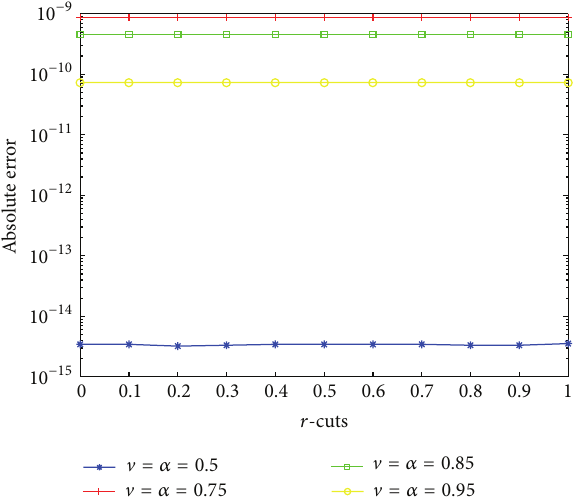
Figure 8: The absolute error for different values V = 𝛼 with 𝑚 = 8 , = 0.014 , and 𝑘 = 0.001 . 𝑘 1 2